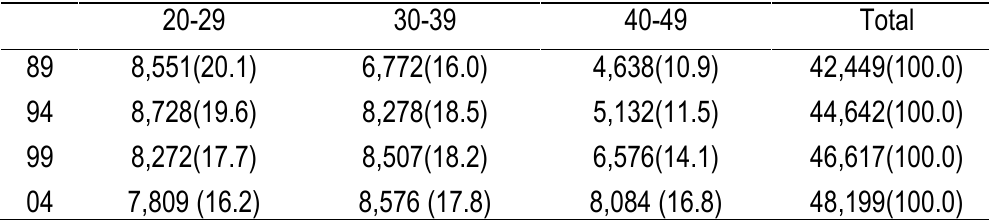
Figure 1. Gaps in the number of freshmen Table 7. Number and proportion of Korean population by age groups (thousand persons,